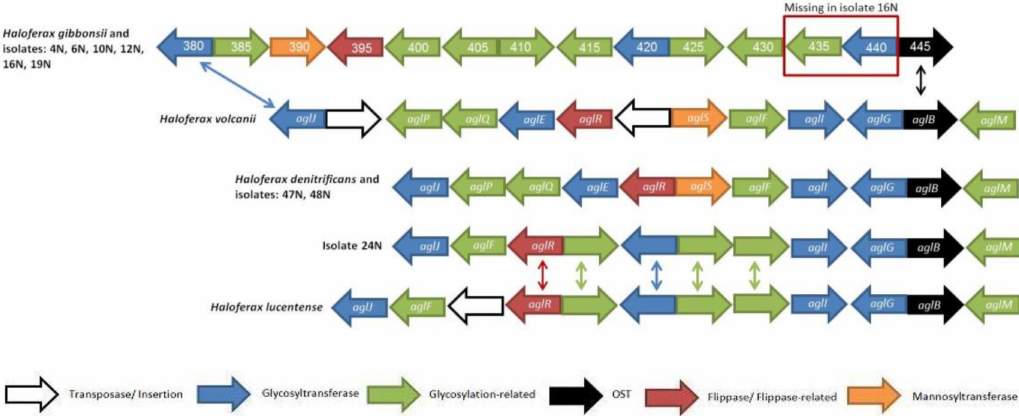
Figure 2. Schematic presentation of the aglB -based glycosylation clusters of four different Haloferax strains and the nine Haloferax isolates. The sizes of the genes are arbitrary. Arrows in between clusters indicate homology. The legend describes gene function according to the color scheme at the bottom. Protein function prediction was performed using HHpred [35]. Based on Figure 2 from Ref.